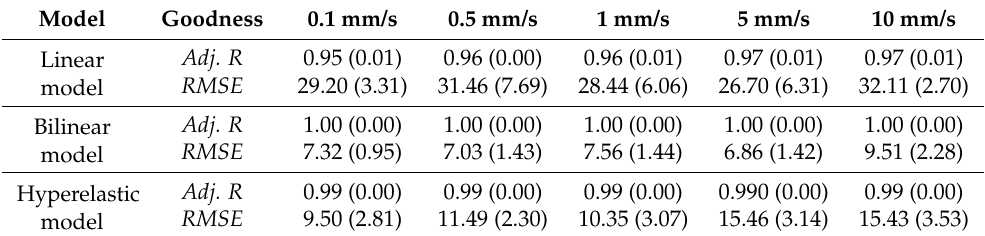
Table 1. Goodness of fit for the mathematical models of Equations (3)–(5) in terms of adjusted R-square and RMSE at each loading velocity in the load-to-failure test. Values are given as mean (SD) for the 8-sample